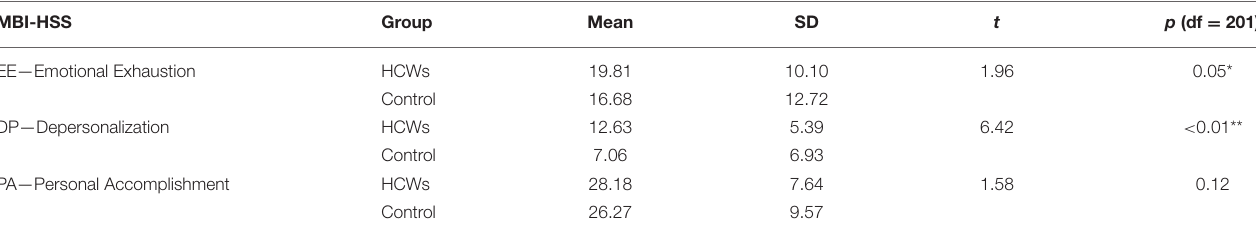
TABLE 2 | Mean, t -test, and p -value for the comparison between groups in the Maslach Burnout Inventory—Human Services Survey (MBI-HSS) (only working respondents were considered: N = 96). MBI-HSS Group